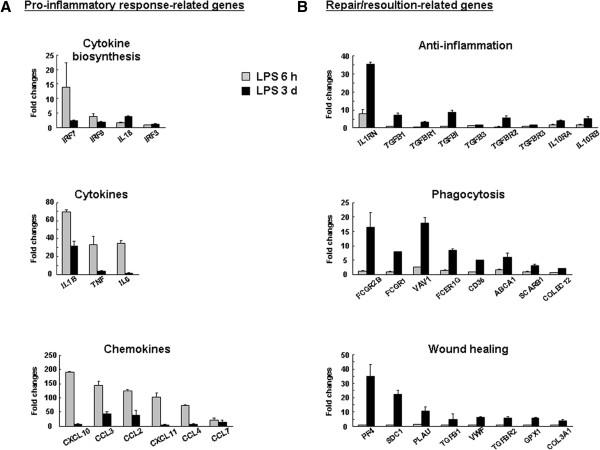
Microarray analysis of mRNA expression in the LPS-injected SNpc. mRNA expression profiles were compared in intact, and 3 h and 3 d after LPS-injected brain. For each microarray sample, brain tissue blocks (2 × 2 × 2 mm) were obtained from four animals, and total RNA was extracted as described in “Materials and Methods”. Relative mRNA levels of proinflammatory response-related genes (A) and repair/resolution-related genes (B) at 6 h and 3 d after LPS injection are shown as fold-changes normalized to that in the intact SNpc. Data shown are representative of two independent experiments.